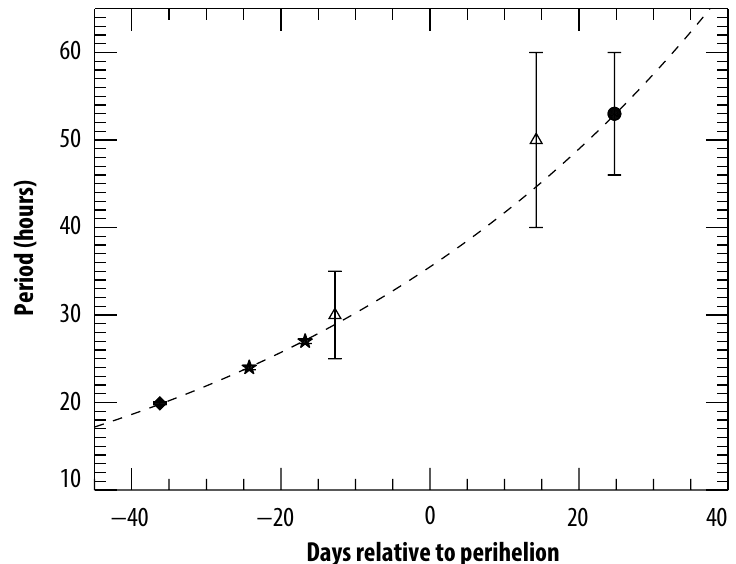
Figure 3. The rotation period of comet 41P/Tuttle–Giacobini–Kresák increased from 20 h to over 46 h during its 2017 apparition, the largest change in rotation period ever observed for a comet. These observations suggest that that the comet rapidly evolved into an excited, unstable spin state. Black diamond: Lowell Discovery Telescope [23]; Black stars: Lowell 31” Telescope [27]; open triangles; TRAPPIST [22]; Filled circle: Swift /UVOT [20]. The dashed line is drawn to guide the eye, after